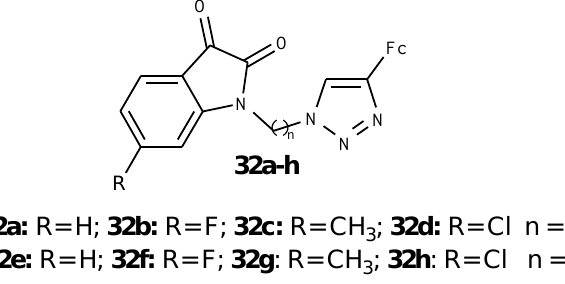
Figure 13. Chemical structure of isatin – ferrocene-based derivative ( 32a – h ).